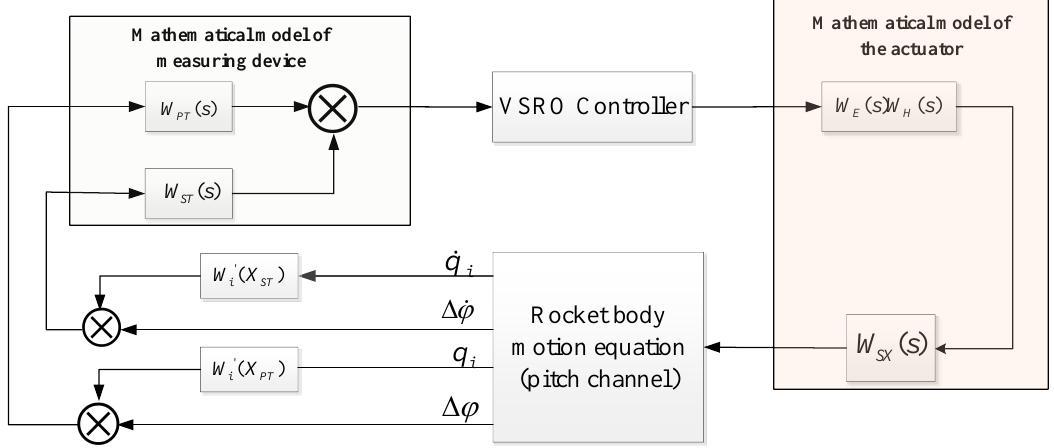
Figure 2. Schematic block diagram of pitch channel attitude control system.